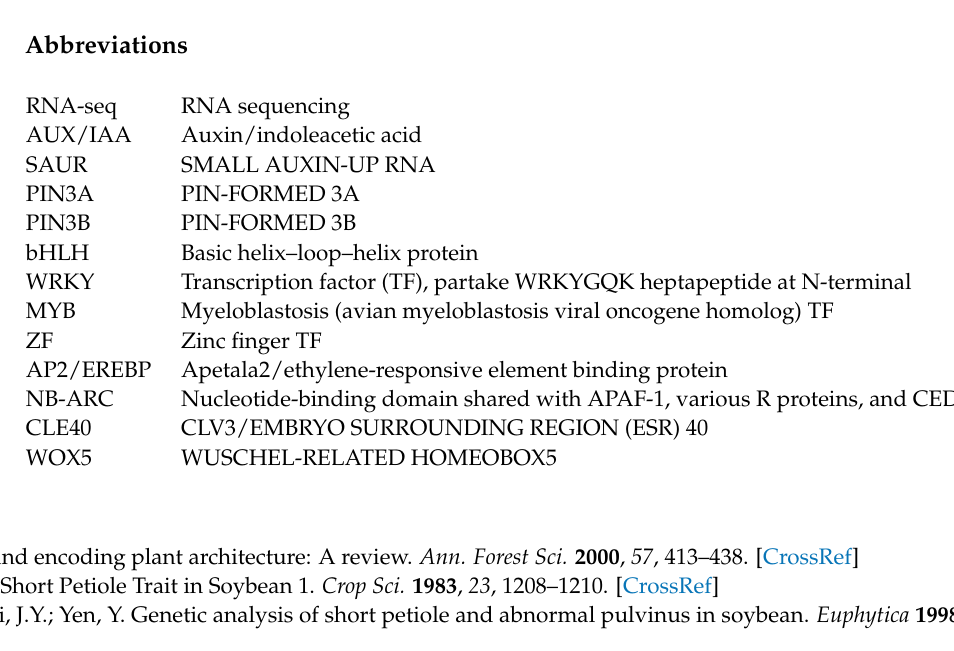
Table S2: The primers used for mapping the spwp2 locus; Table S3: List of the primers used for the qRT-PCR analysis of six candidate genes; Table S4: Summary of re-sequencing data quality of the wild-type and mutant-type DNA pools; Table S5: Mapping information for the wild-type and mutant-type DNA pools by whole-genome re-sequencing; Table S6: Throughput and quality of RNA-seq of the spwp mutant and the wild type (WT); Table S7: The differentially expressed genes between the spwp mutant and the wild type (WT); Table S8: The SNPs in the candidate genes detected by Sanger sequencing; Table S9: Auxin-related genes differentially expressed between the spwp mutant and the wild type